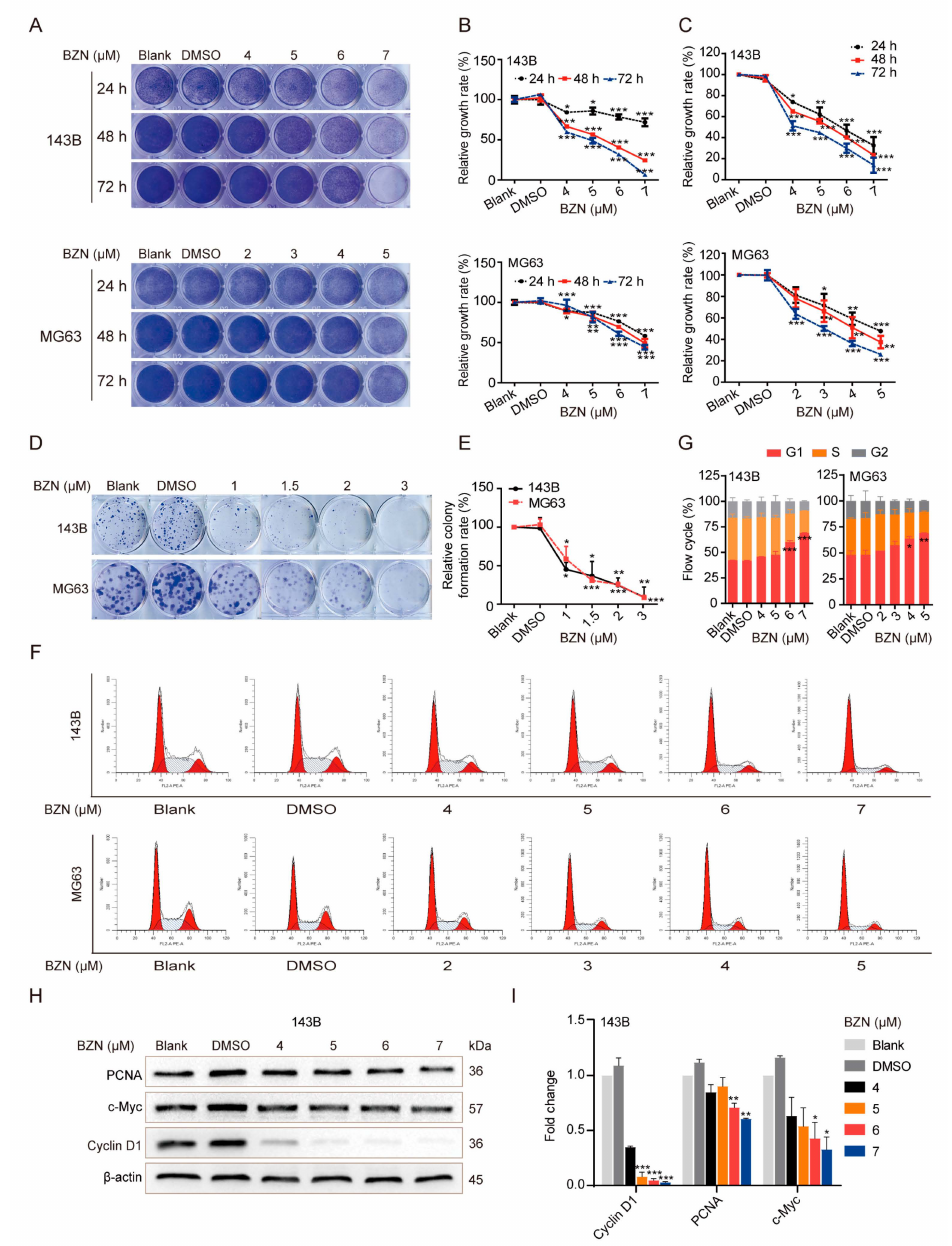
Figure 1. BZN suppresses the proliferation and induces G1 phase arrest in OS cells. ( A ) The effect of BZN on cell proliferation of OS cells (crystal violet staining). ( B ) Quantitative analysis of crystal violet staining. ( C ) The effect of BZN on cell viability of OS cells (MTT). ( D ) The effect of BZN on the colony formation ability of OS cells (colony formation assay). ( E ) Quantitative analysis of relative colony forming rate. ( F , G ) The effect of BZN on the cell cycle of OS cells (flow cytometry). ( H ) The effect of BZN on the protein levels of PCNA, c-Myc, and cyclin D1 in 143B cells. ( I ) Relative quantitative analysis of Western blot. Data are shown as mean ± SD from three independent